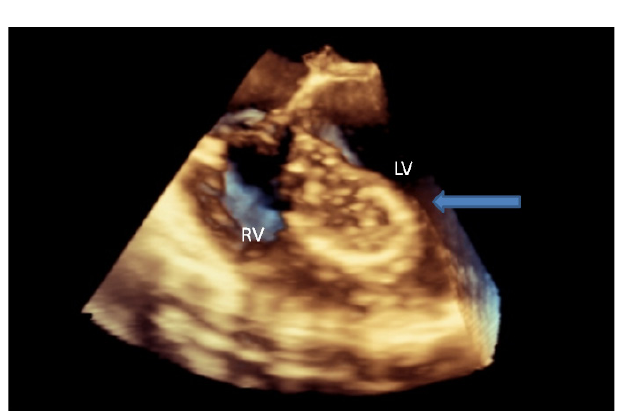
Fig. 1 – Echocardiographic view of the hydatid cyst. LV=left ventricle; RV=right ventricle